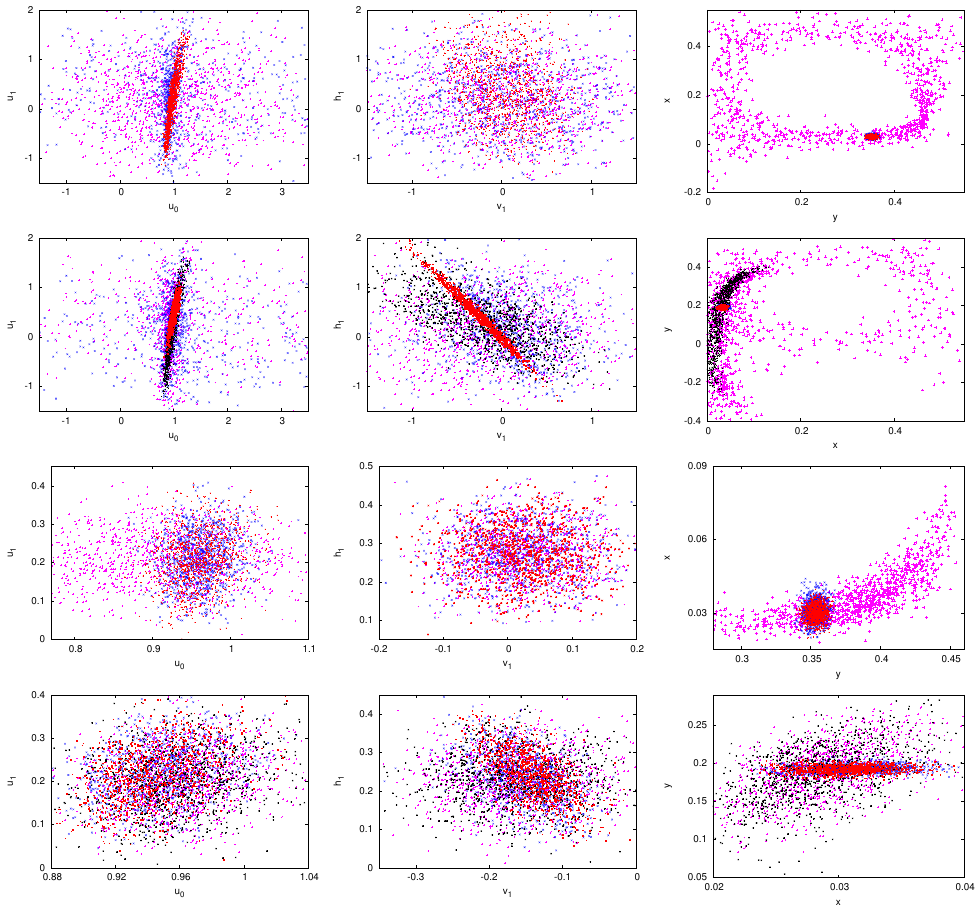
Fig. 10. Same as Figs. 4 (broad prior and infrequent observations, top row is update step at the first observation, second row at second observation) and 5 (narrow prior and infrequent observations, third row is update step at the first observation, bottom row at second observation), except that the observations from the trajectory near the saddle are assimilated.